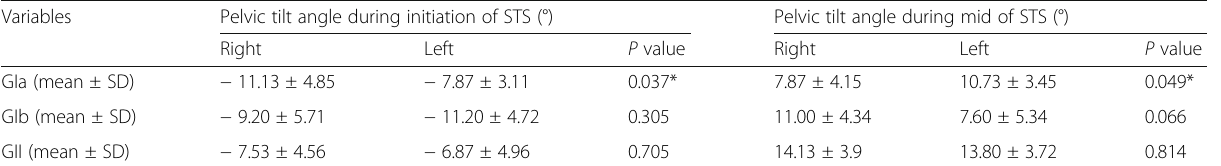
Table 3 Mean values of anterior pelvic tilt angles during initiation and mid of sit to stand task between two tested sides of three groups